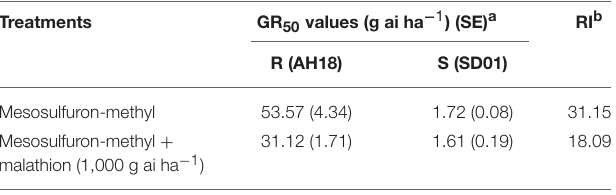
TABLE 1 | The effects of mesosulfuron-methyl on Alopecurus aequalis growth with and without malathion pretreatment.